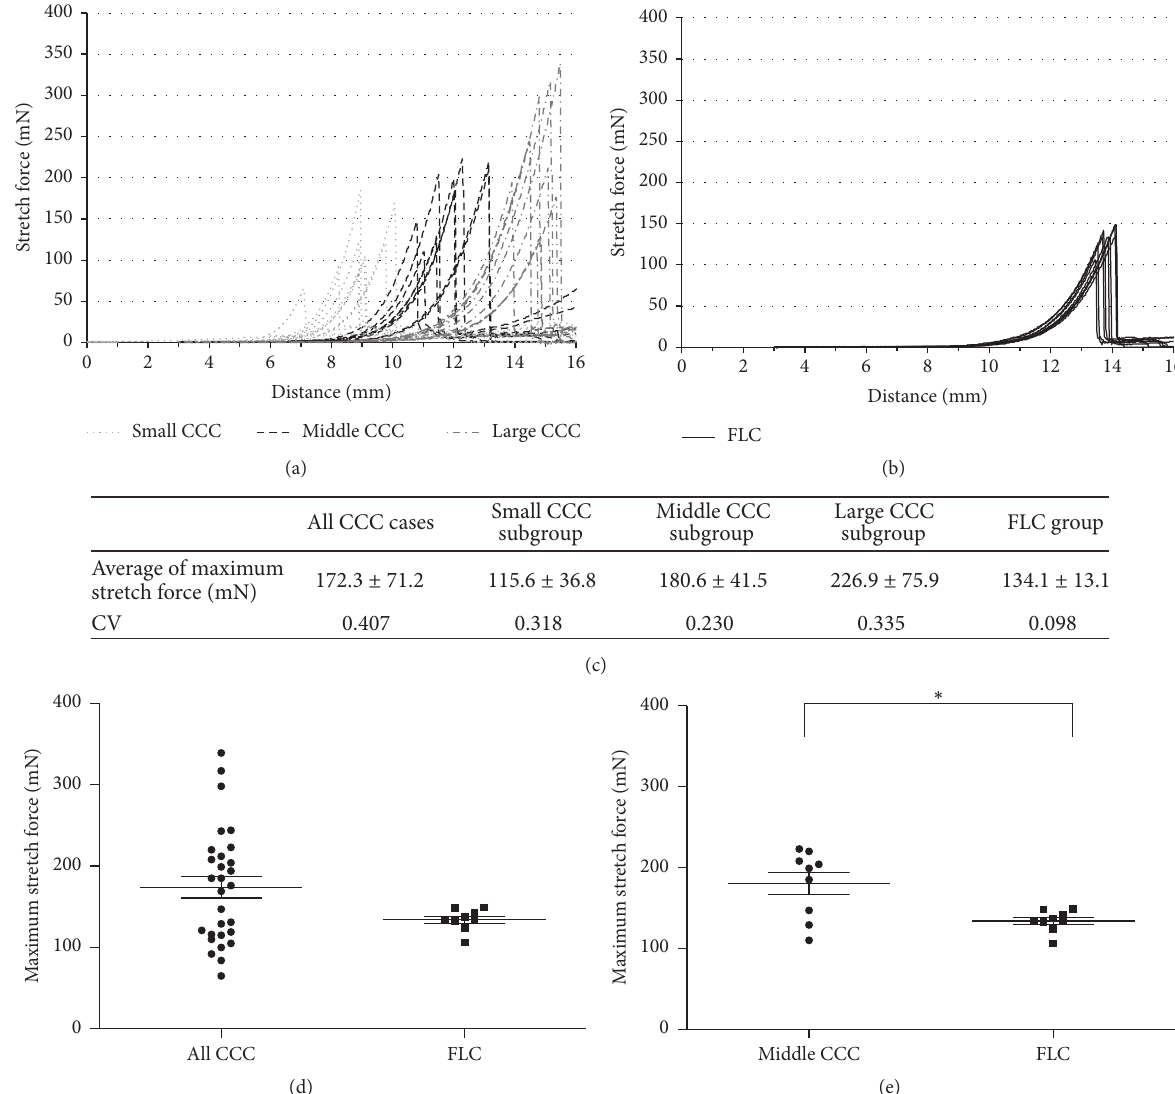
Figure 4: Results of the capsule stretch experiments. Association between stretch distance and stretch forces during the capsule stretch experiments in the CCC group (a) and FLC group (b) is shown. There were large variations in maximum stretch force and maximum stretch distance within the CCC group, while there was less variation in the FLC group in this regard. The average maximum stretch force and the coefficient of variation (CV) in each group are shown (c). There were no differences in mean stretch force between the CCC group and the FLC group (d). However, the middle CCC subgroup showed higher stretch forces than the FLC group (e). ∗ 𝑝 < 0.05 .